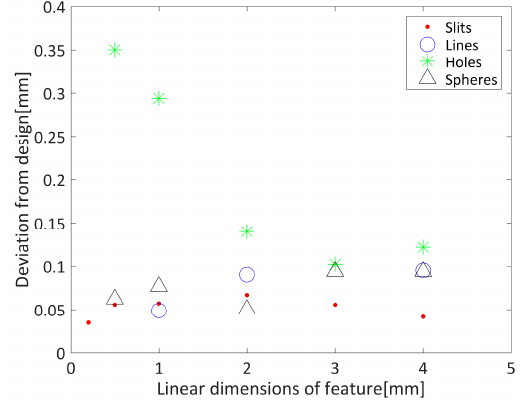
Figure 8. Summary of linear dimension measurements as compared to the computer-aided design (CAD) for the four test objects.